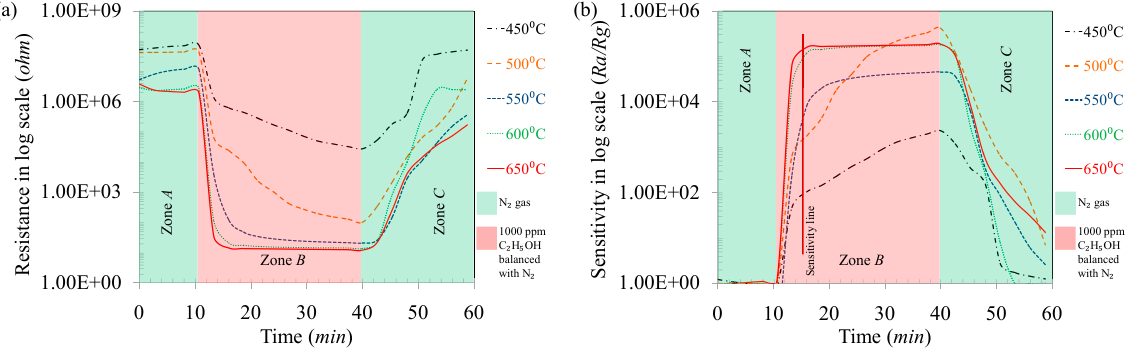
H OH at different 2 5